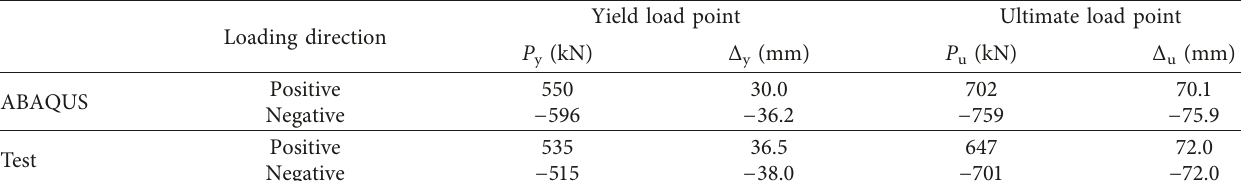
Table 3: Results comparison.